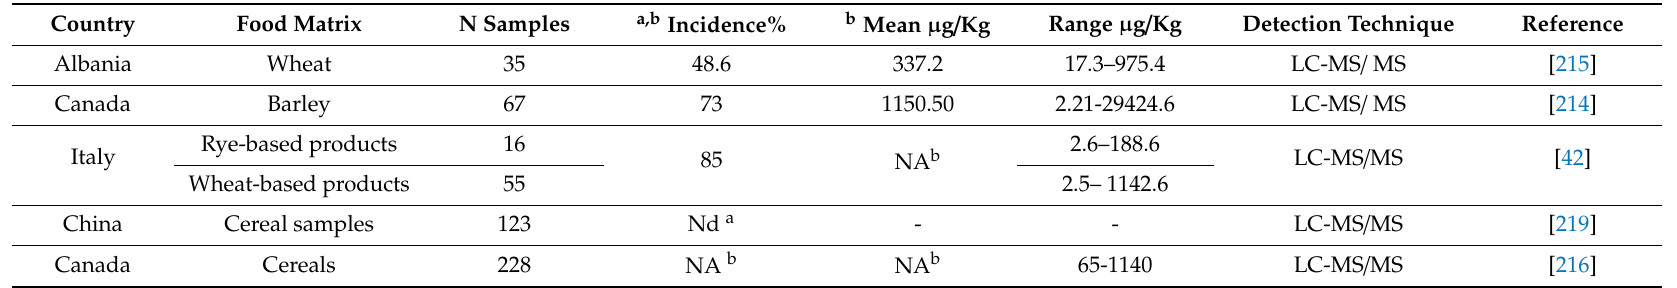
Table 10. Representative studies on the occurrence of Ergot alkaloids distribution ( µ g / Kg) in food samples around the world during 2014–2019.